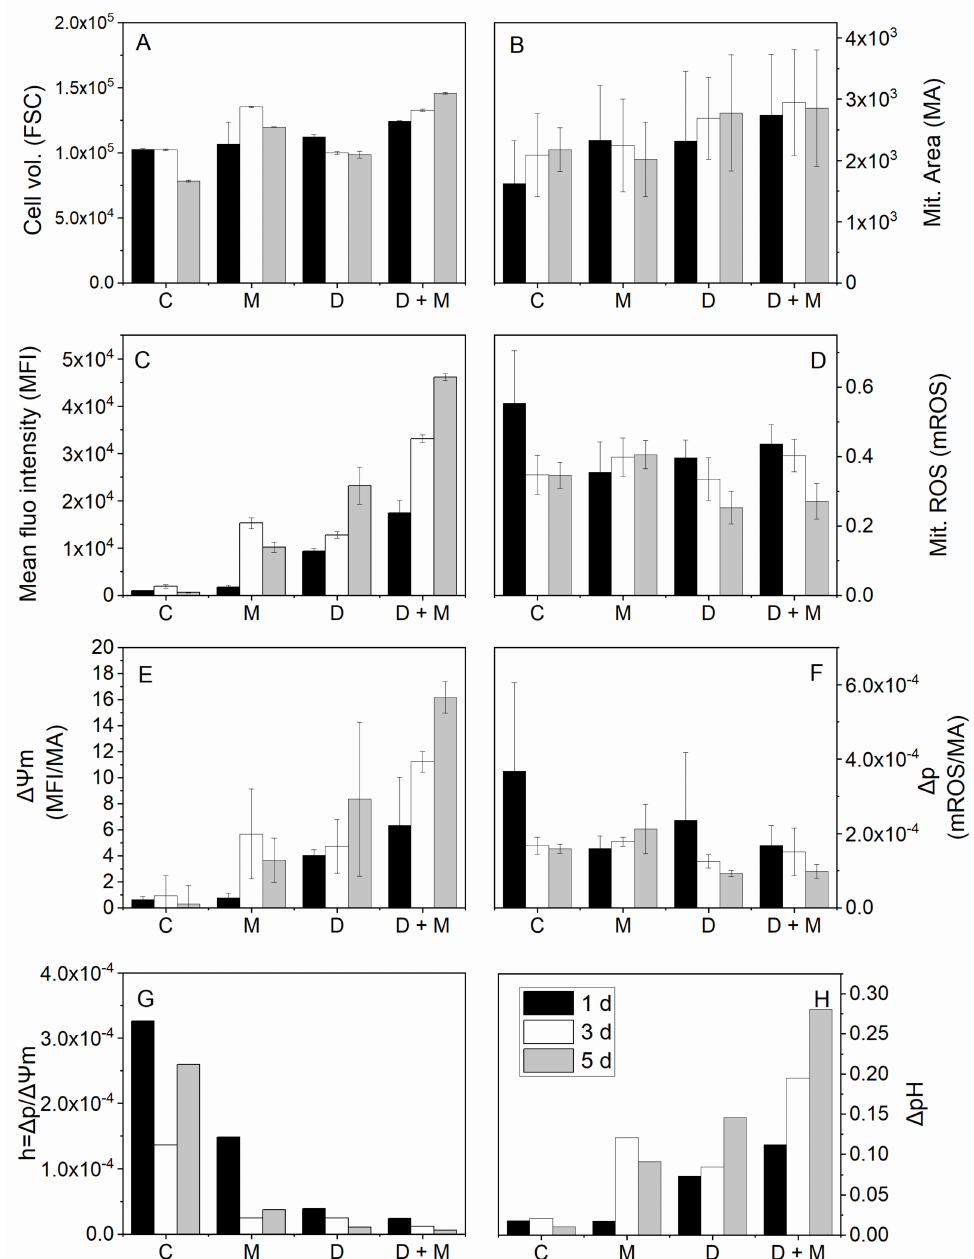
Figure 5. Mitochondrial activity and ROS generation in hyperosmotic culture conditions combined with lipoic acid and hydroxycitrate drugs (a.u.). C = control, M = mannitol condition, D = drugs condition, D + M = drugs and mannitol combination. Black bars are measurements of one day (1d) of culture, white bars are for three days (3d), and grey bars are for five days (5d) of culture. ( A ) Cell volume estimation based on forward scatter signal (FSC) parameter. ( B ) Mean mitochondria area, where determined, based on confocal microscopy images. ( C ) Mean fluorescence intensity (MFI) of rhodamine 123 used here to estimate mitochondrial membrane potential. ( D ) MitoTracker Red CM-H2XRos fluorescence intensity-reported mitochondrial ROS generation. ( E ) Mitochondrial mean fluorescence intensity normalized by mitochondria area ratio is intended to represent the mean mitochondrial membrane potential ( ∆Ψ m). ( F ) Mitochondrial ROS (mROS) normalized by mitochondrial area (MA) roughly provides information on the mean mitochondrial membrane protonmotive force ( ∆ p). ( G ) Ratio hypothesized as an estimation of mitochondria horsepower (h = ∆ p/ ∆Ψ m). ( H ) Estimated mitochondrial proton gradient ( ∆